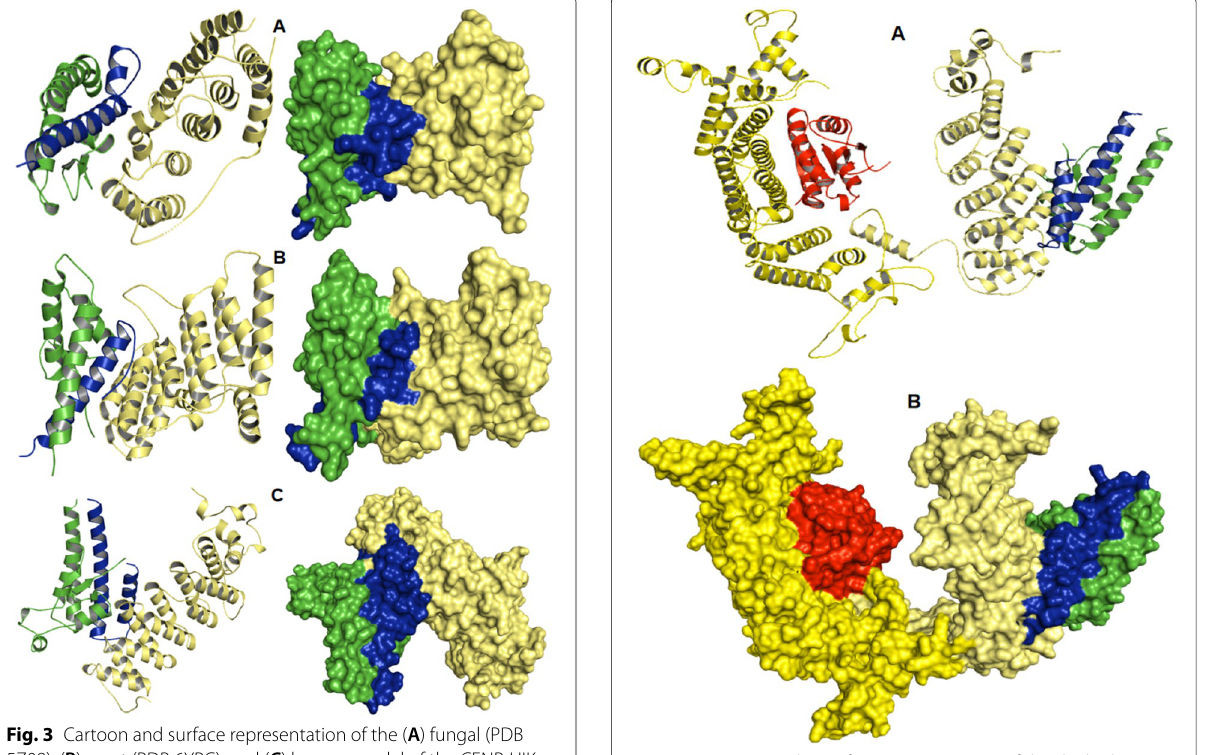
Fig. 4 A Cartoon and B surface representation of the docked hs CENP-HIKM complex. The hs CENP-I is colored in two shades of yellow in order to distinguish the N-terminal (pale yellow) from the C-terminal. The binding of the hs CENP-M to the C-terminal of hs CENP-I shows great resemblance with the previously described binding of Ran to importin-β. The hs CENP-H, hs CENP-K and hs CENP-M are colored in blue, green and red,